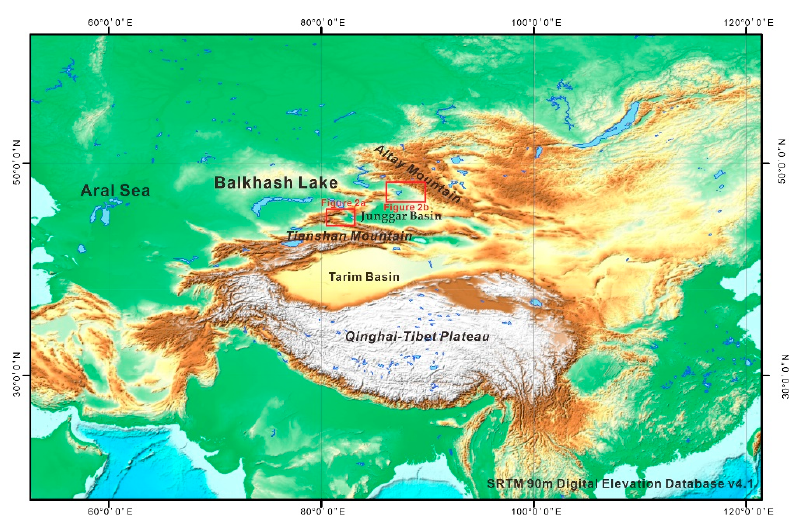
Figure 1. The location of the Altay and Tianshan Mts. in Central Asia and the geographical location of Figure 2a,b). The topography was based on SRTM 90m Digital Elevation Database v4.1 (http://srtm.csi.cgiar.org, accessed on 20 August 2021).